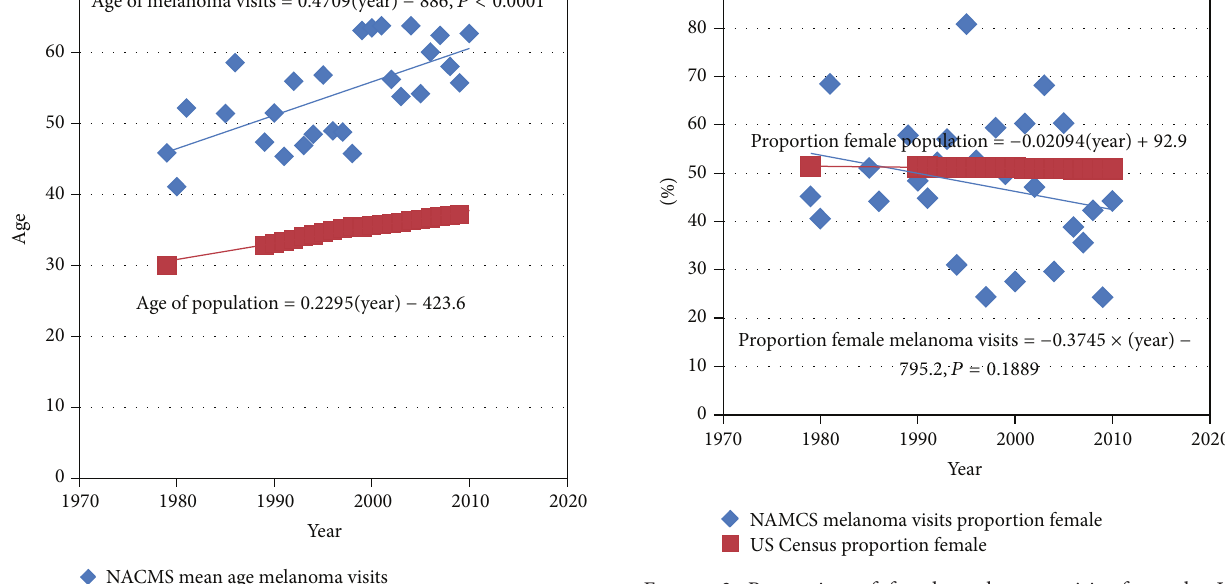
Figure 3: Proportion of female melanoma visits from the US National Ambulatory Medical Care Survey (NAMCS) from 1979 to 2010 compared to proportion female in